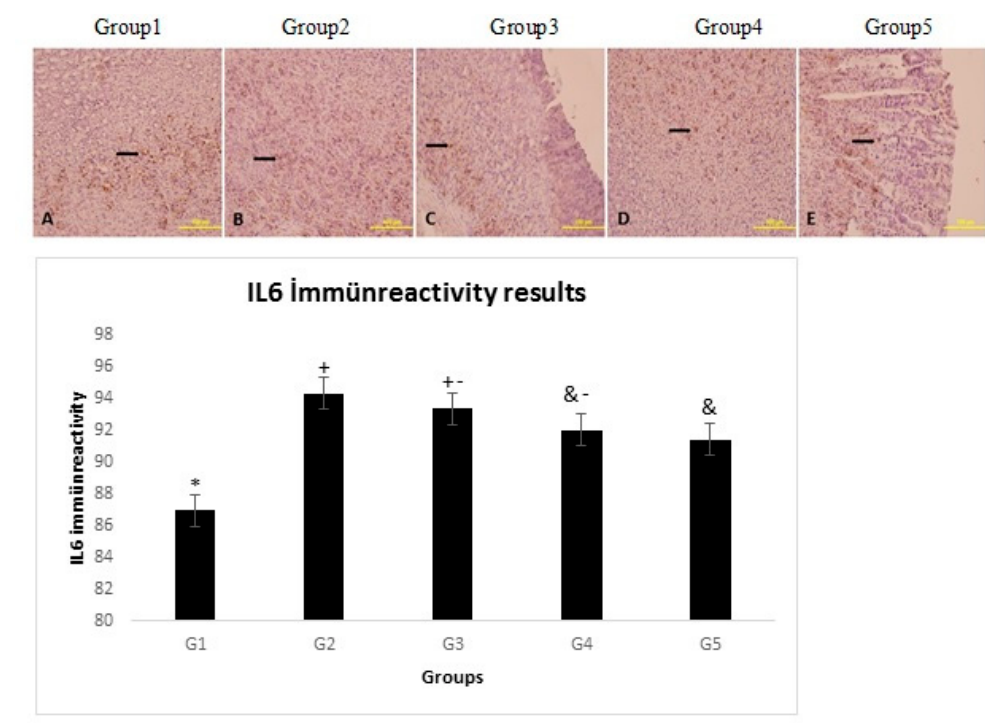
Figure 1. Immunohistochemical localization of IL-6 expression of the stomach tissue and semiquantitative results of IL-6 content obtained by densitometric analysis of immunohistochemistry in different groups. (Statistical analysis was used One-way ANOVA, posthoc Tukey test). There are significant differences between the groups with different icons (+, -, *,